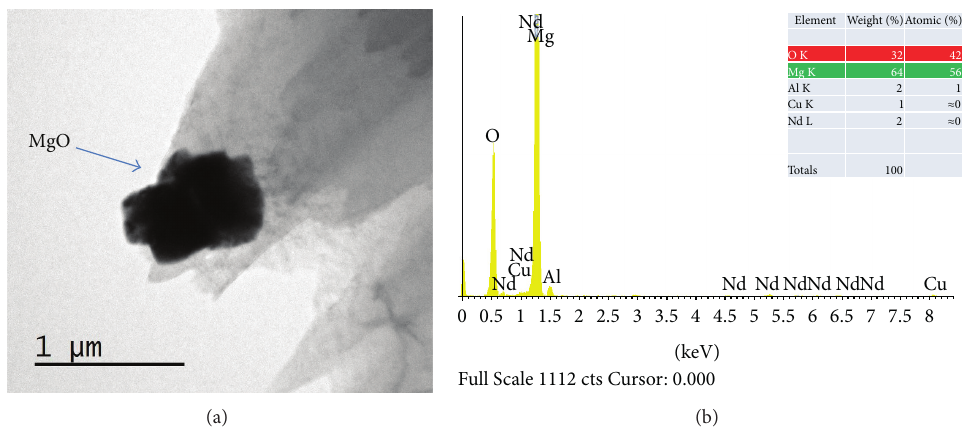
Figure 3: (a) BF TEM of MgO particle in EL 21 + Al 2 O 3 -AlOOH composite; (b) EDS spectrum of MgO particle.